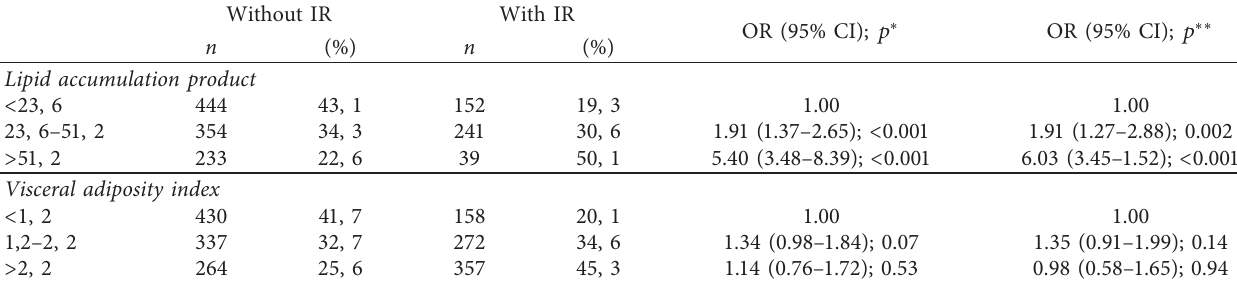
Table 3: Association between adiposity indexes and insulin resistance (Maracaibo, Venezuela). Without IR With IR